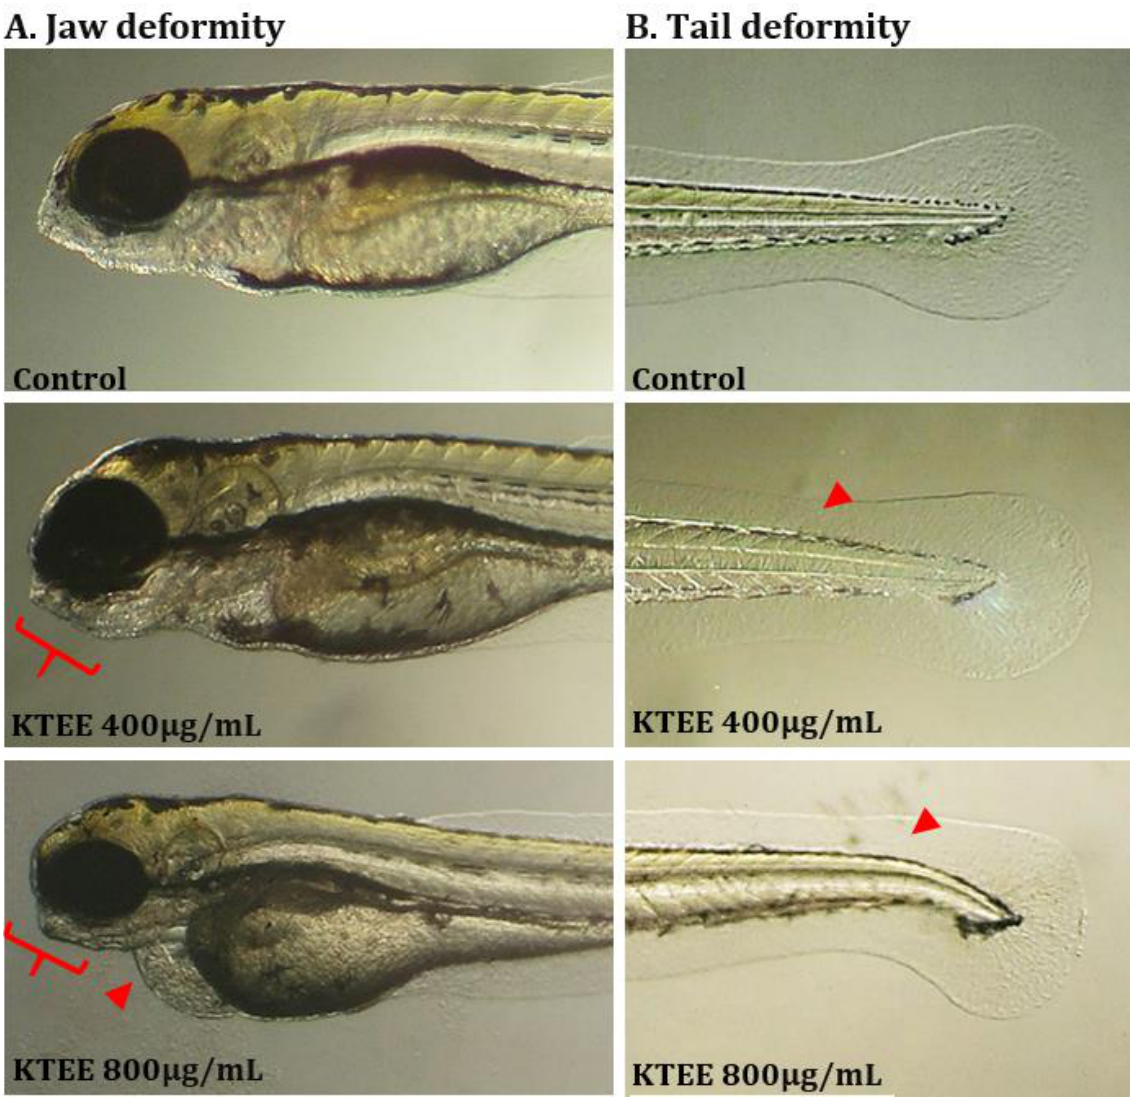
Figure 4. A change in the morphology of zebrafish larvae at 96 hpf. All pictures showed lateral view; anterior